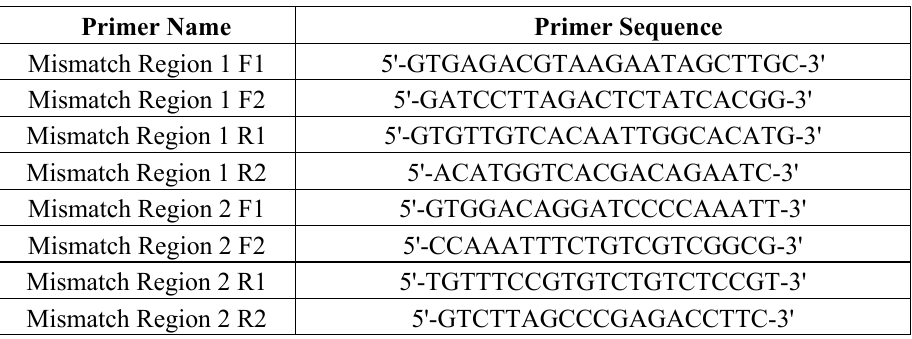
Figure 6. Strain-specific PCR assays differentiate ATCC 22122 strain of GPCMV from CIDMTR strain. ( a ) Primers were designed to amplify across discontinuous/unique regions as demonstrated in Figure 3b. Lane 1, kb ladder; lane 2, mismatch region 1 F1/R1, ATCC; lane 3, mismatch region 1, F1/R1, CIDMTR; lane 4, mismatch region 1, no template control; lane 5, mismatch region 1 F2/R2, ATCC; lane 6, mismatch region 1 F2/R2, CIDMTR; lane 7, mismatch region 1 F2/R2, no template control; lane 8, mismatch region 2 F1/R1, ATCC; lane 9, mismatch region 2 F1/R2, CIDMTR; lane 10, mismatch region 2 F1/R1, no template control; lane 11, mismatch region 2 F2/R2, ATCC; lane 12, mismatch region 2 F2/R2, CIDMTR; lane 13, mismatch region 2 F2/R2, no template control. ( b ) Restriction polymorphisms were as predicted by DNA sequence. PCR amplification products were digested with enzymes as indicated. Lane 1, kb ladder; lane 2, mismatch region 1 F1/R1 ATCC, Bgl 2; lane 3, mismatch region 1 F1/R1 CIDMTR, Bgl 2 ; lane 4, mismatch region 1 F2/R2 ATCC, Bgl 2; lane 5, mismatch region 1 F2/R2 CIDMTR, Bgl 2; lane 6, mismatch region 1 F1/R1 ATCC, BamH I; lane 7, mismatch region 1 F1/R1 CIDMTR, BamH I; lane 8, mismatch region 1 F2/R2 ATCC, BamH I; lane 9, mismatch region 1 F2/R2, BamH I; lane 10, mismatch region 1 F1R1 ATCC, EcoR V; lane 11, mismatch region 1 F1/R1 CIDMTR, EcoR V; lane 12, mismatch region 1 F2/R2 ATCC, EcoR V; lane 13, mismatch region 1 F2/R2, EcoR V; lane 14, mismatch region 2 F1R1 ATCC, EcoR I; lane 15, mismatch region 2 F1R1 CIDMTR, EcoR I; lane 16, mismatch region 2 F2/R2 ATCC, EcoR I; lane 17, mismatch region 2 F2/R2, EcoR